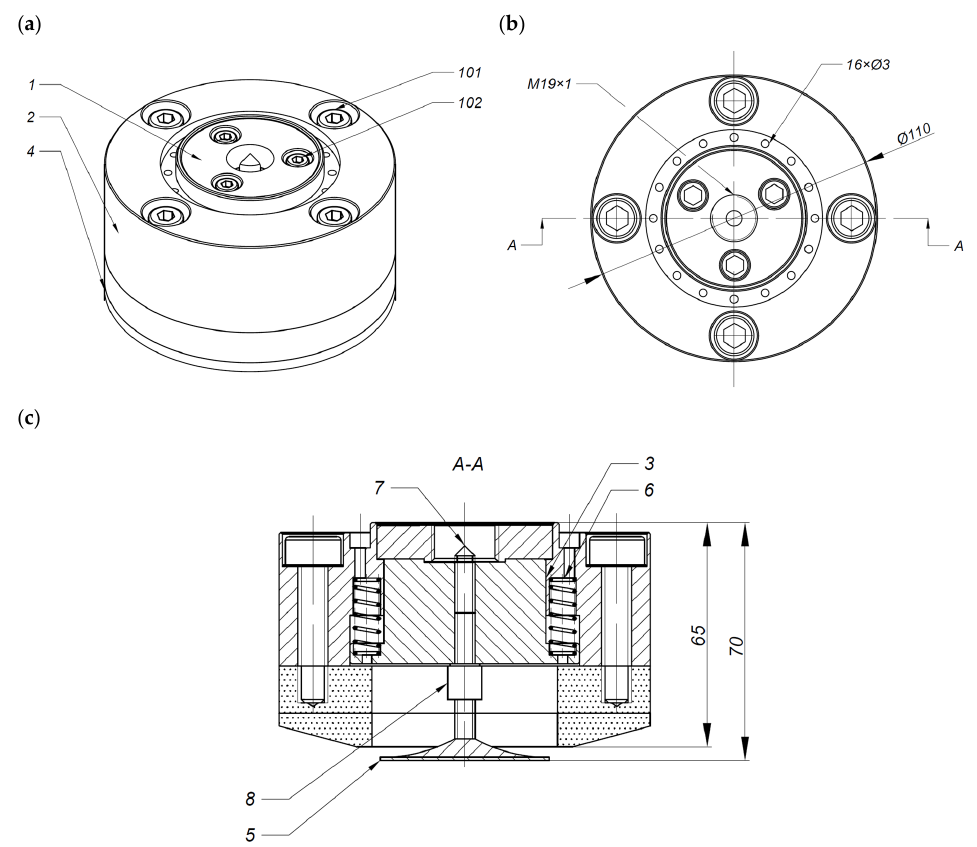
Figure 2. Technical drawing of a prototype of a dual-tool grinding head (1—ER14 adapter, 2—outer body, 3—inner body, 4—Ø110 grinding wheel, 5—Ø50 3M Trizact ® grinding wheel, 6—0.8 × 7.7 × 25 pressure spring, 7—centering shaft, 8—prone grinding wheel spacer, 101—M8 bolt, 102—M5 bolt): ( a ) isometric view; ( b ) top view; ( c ) A-A cross-section.